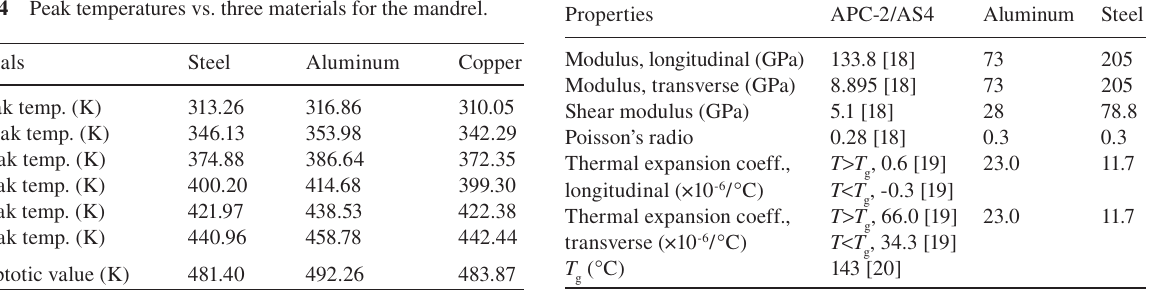
Table 4 Peak temperatures vs. three materials for the